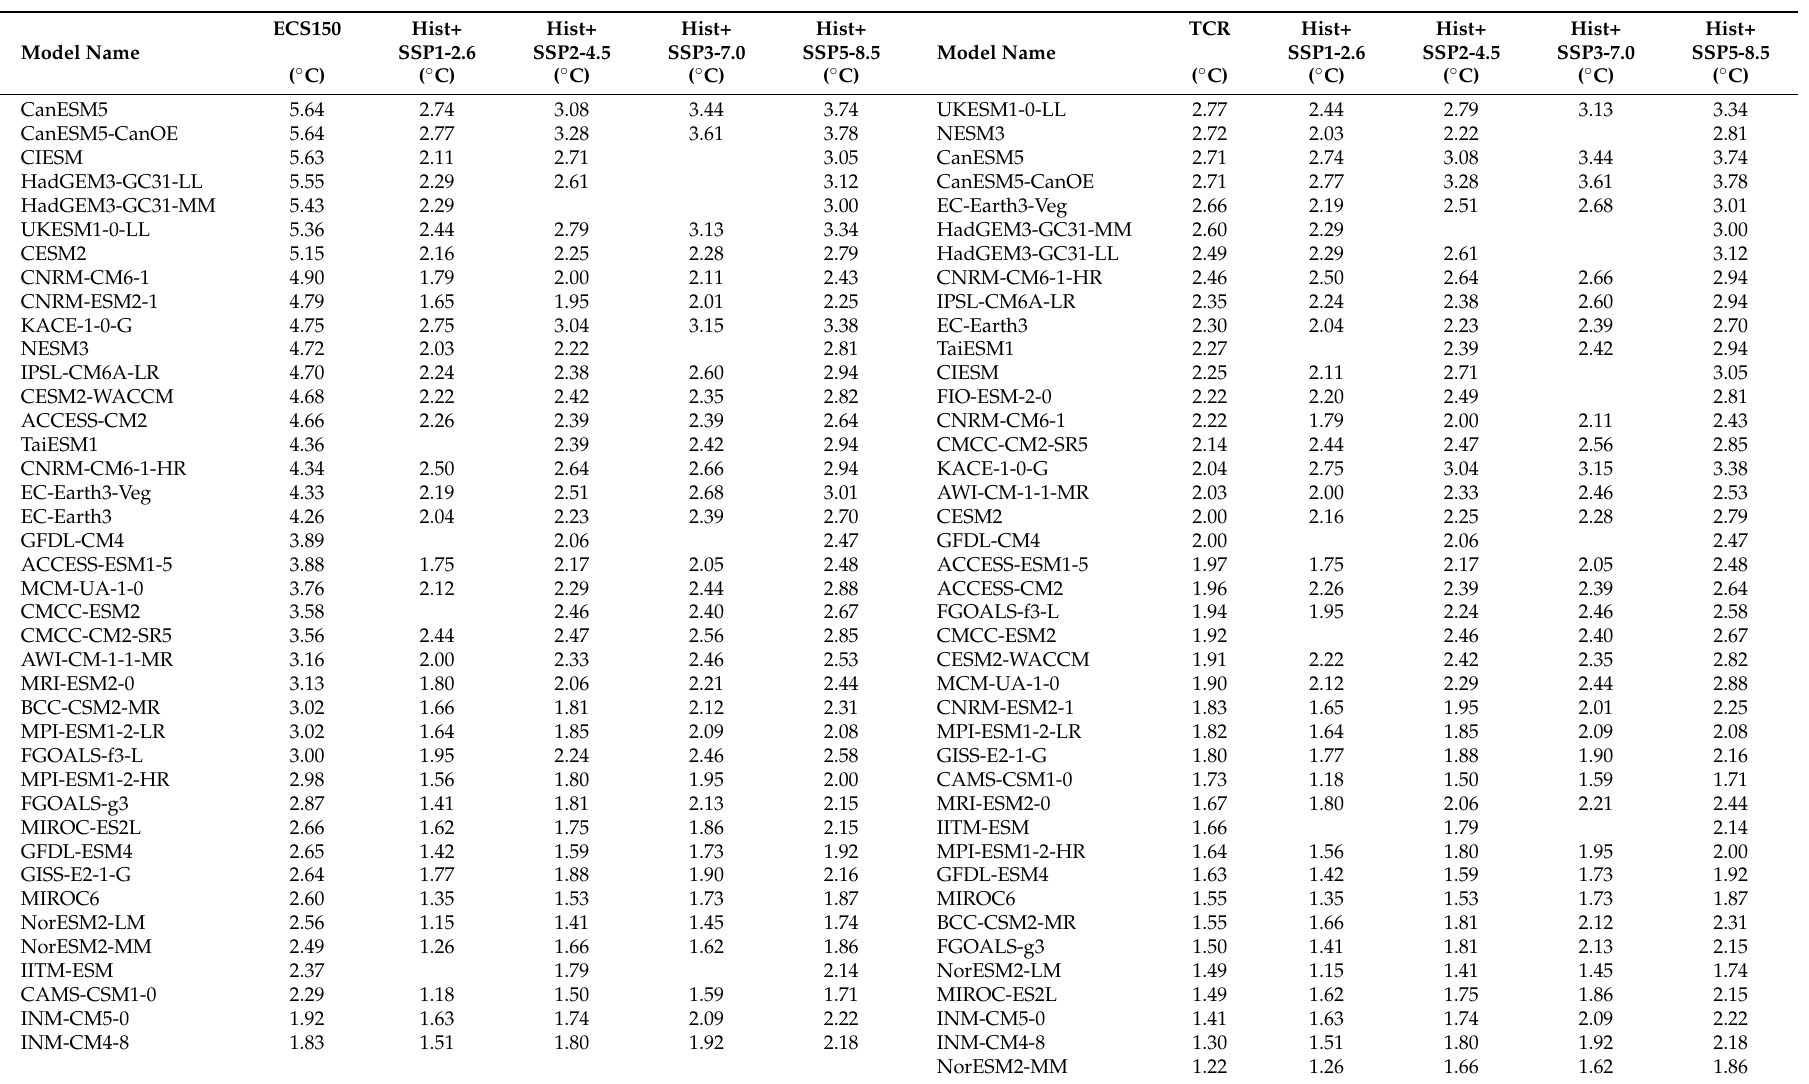
Table A3. Temperature change from 1850–1899 to 2045–2055 for the CMIP6 Global Circulation Models (GCMs). The ranking uses ECS-150 and TCR from Hausfather et al.